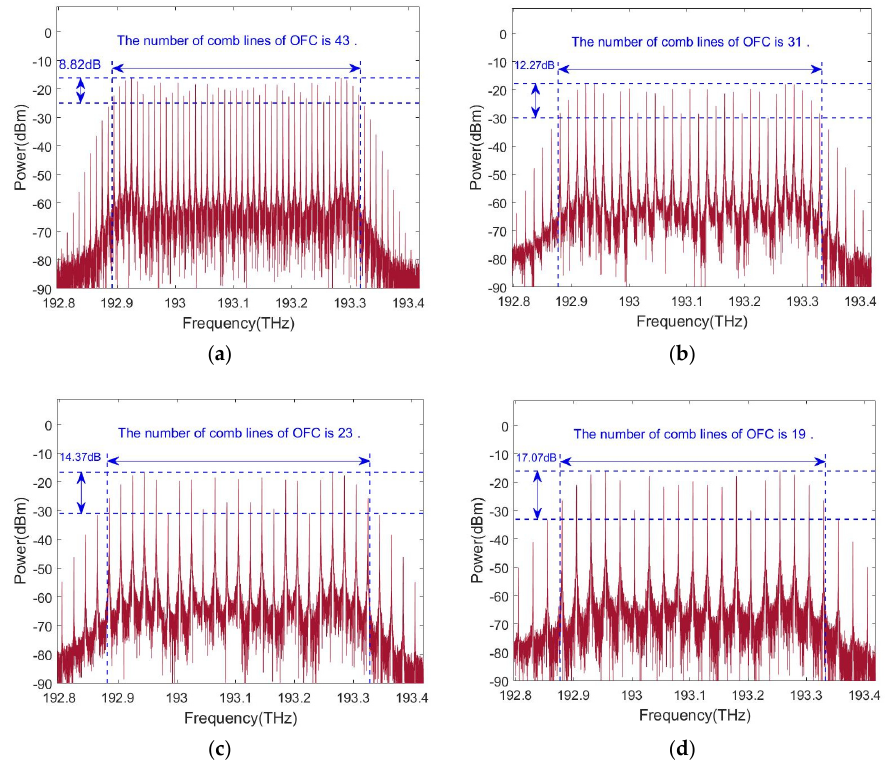
Figure 4. The optical spectra of OFC with a different frequency of injected RF current: ( a ) 10 GHz, ( b ) 15 GHz, ( c ) 20 GHz, and ( d ) 25 GHz.